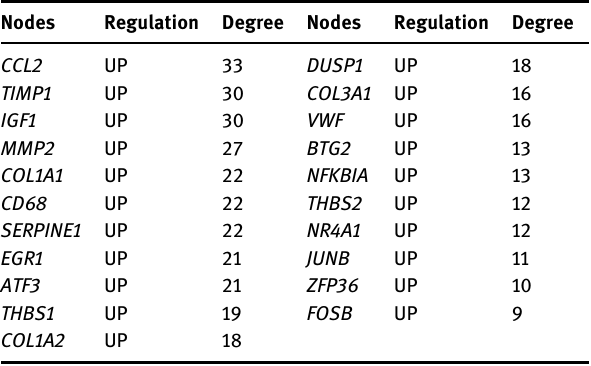
Table 1: The list and interaction degree of the 21 upregulated radiation - associated genes in the module of the PPI network of breast cancer Nodes Regulation Degree